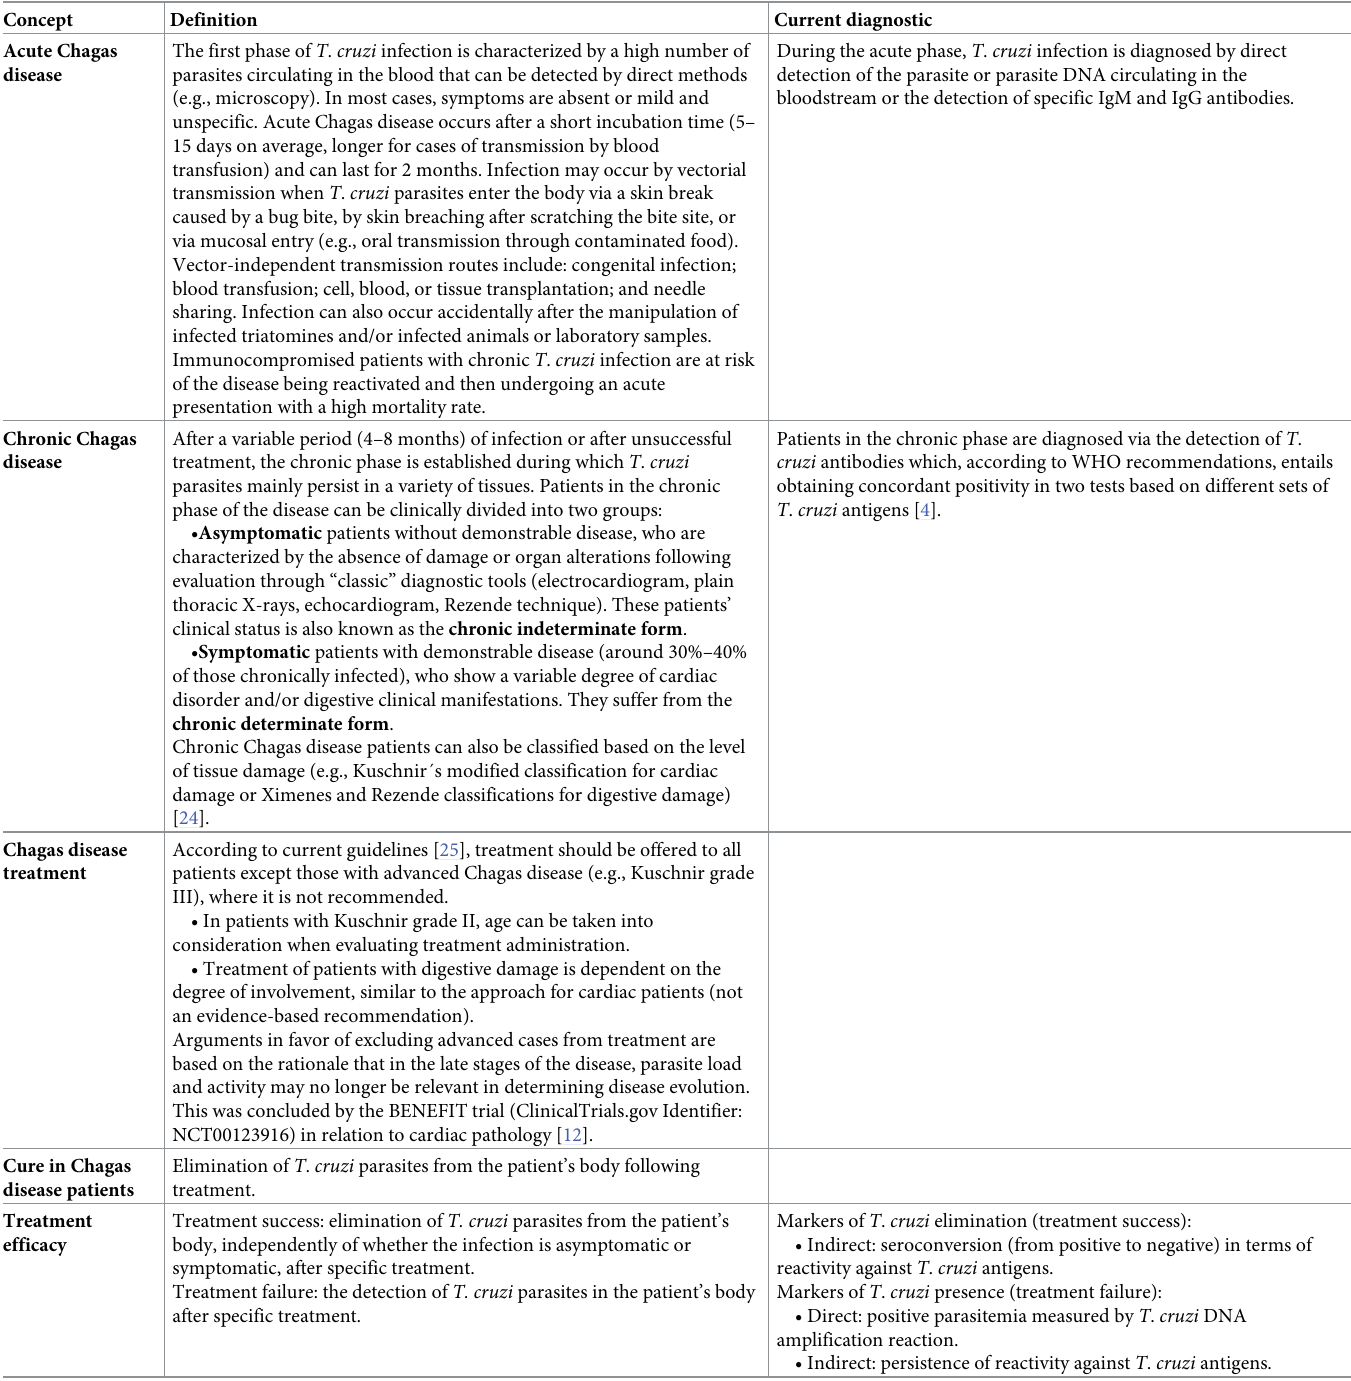
Table 1. Definitions used to develop the TPP for a test for the early assessment of treatment efficacy in Chagas disease